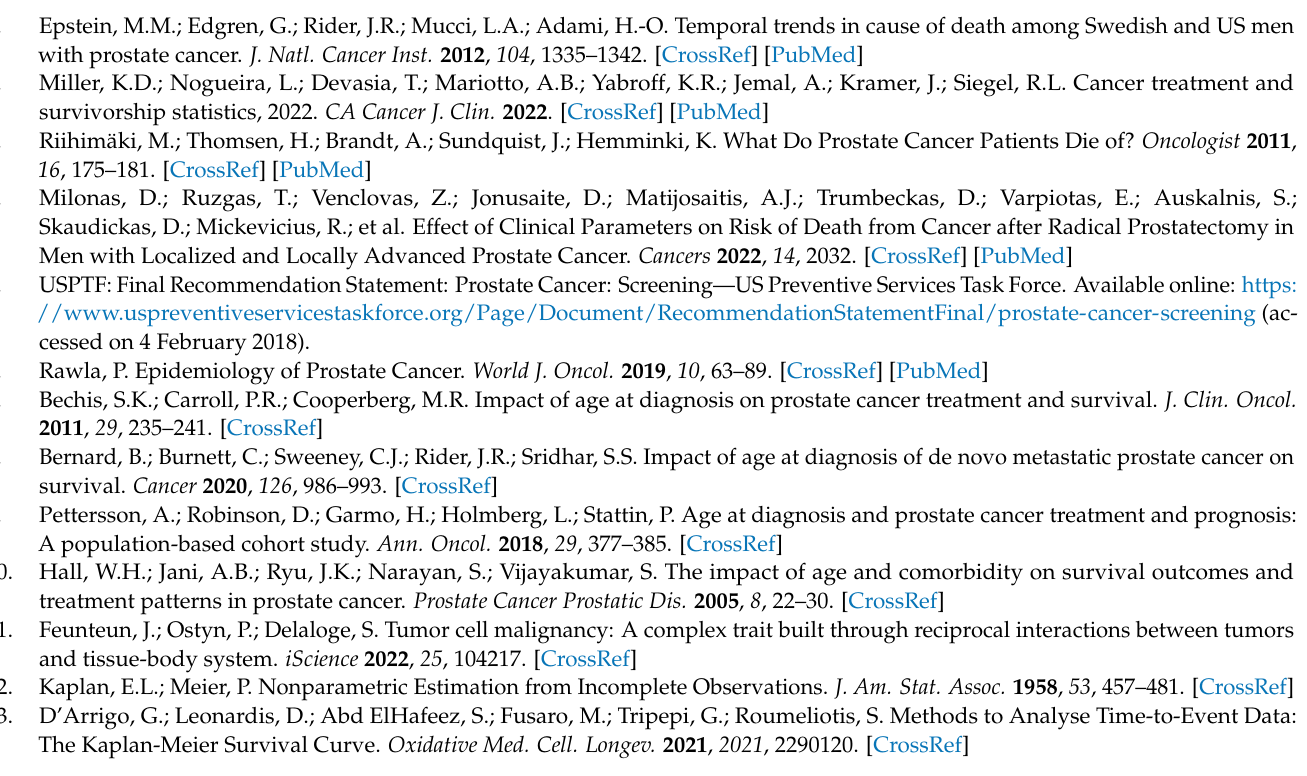
curve, by age at diagnosis; Figure S2: Actuarial prostate cancer survival curve, by Gleason score; Figure S3: Actuarial prostate cancer survival, by race; Figure S4: Actuarial prostate cancer survival curve, by metastatic status at presentation; Figure S5: Percentage of all deaths of prostate cancer by year of follow-up, by age at diagnosis; Figure S6: Percentage of all deaths of prostate cancer by year of follow-up, by Gleason